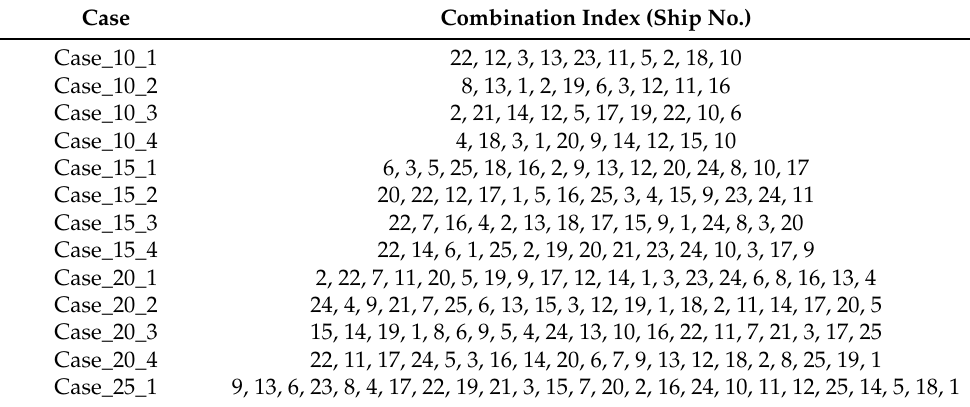
Table 3. Combination of